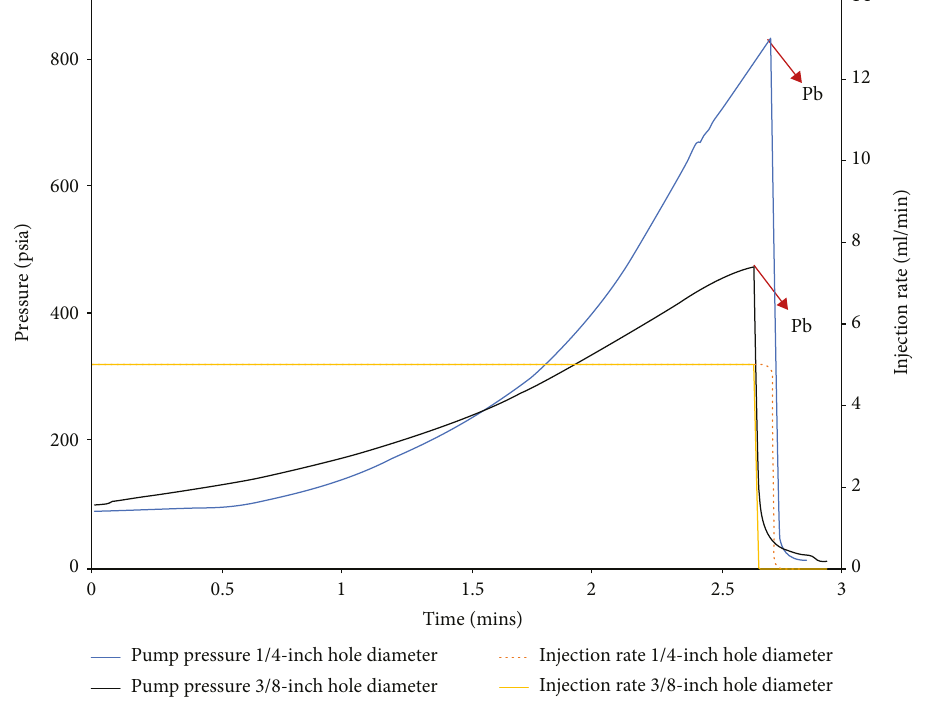
Figure 12: Injection pressure and injection rate pro fi les with time for the thermochemical fracturing experiment on 1/4-inch and 3/8-inch hole diameter blocks. Table 3: A summary of breakdown pressure and breakdown time obtained from fracturing with distilled water and thermochemical. Borehole